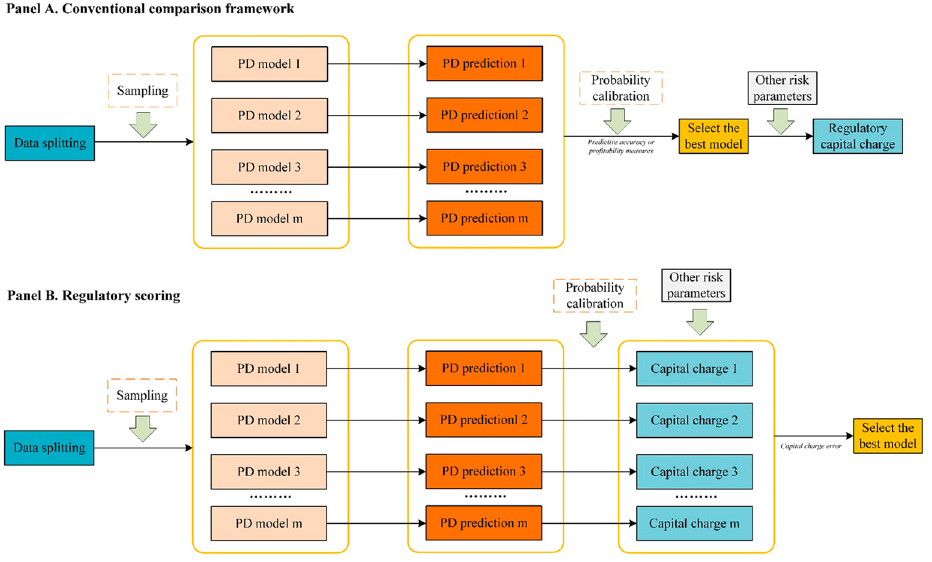
Figure 1. A comparison of convention comparison framework and the proposed regulatory scoring (the dashed boxes indicate the optional